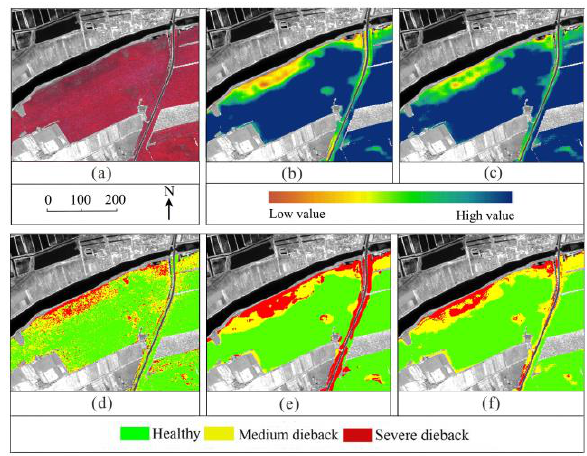
Figure 4. Comparison between (a) a subset of false color IKONOS composite image (NIR band/red band/green band vs R/G/B), (b) GLCM texture MEA (B4) calculated from IKONOS NIR band with window size of 13 × 13 and direction 45°, (c) Gi (B4) calculated from IKONOS NIR band with distance value of 5 and the Queen’s neighborhood rule, (d) RF classification result created with the four IKONOS MS bands, (e) RF classification result created with the eight GLCM features calculated from IKONOS NIR band with the window size of 13 × 13 and direction 45°, and (f) RF classification result created with the four Gi features calculated from each IKONOS MS band with the distance value of 5 and Queen’s neighborhood